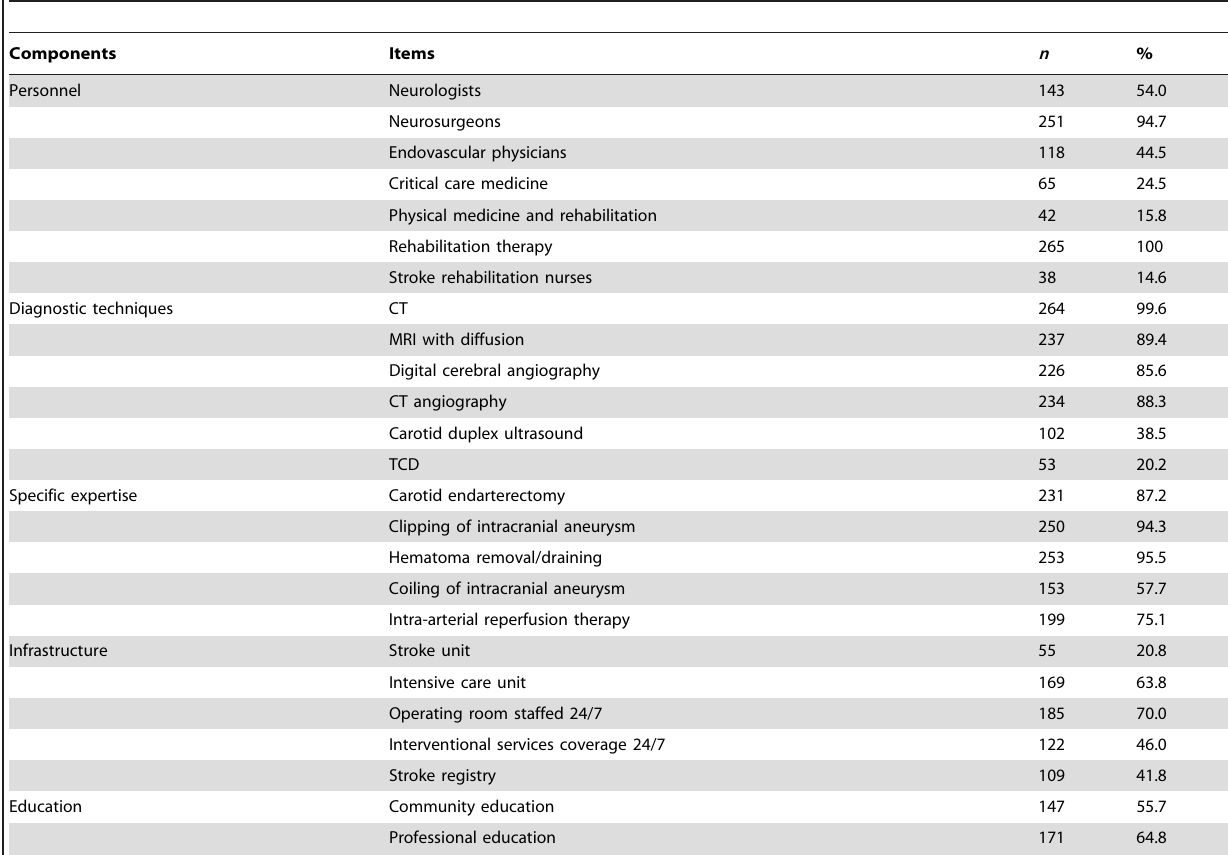
Table 1. Number and percentage of participating hospitals (n=265) with the recommended items of comprehensive stroke care